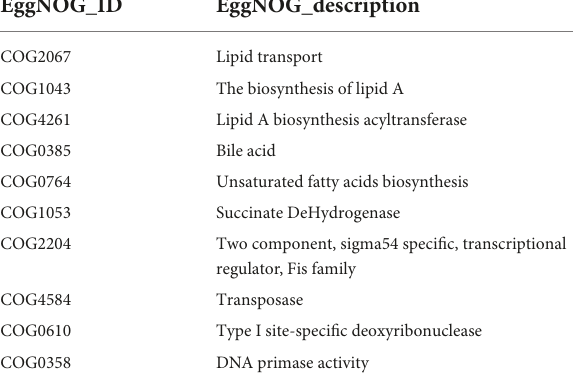
TABLE 2 Difference function in